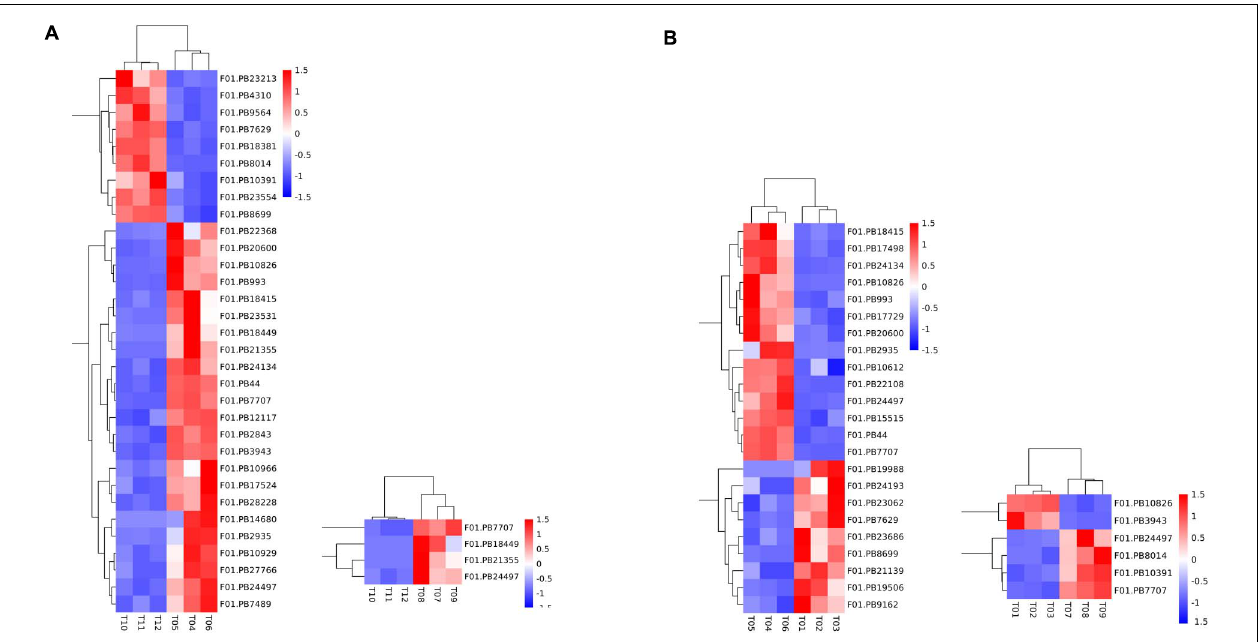
FIGURE 4 | Expression pattern analyses of the flowering-related DEGs. Heatmap of the expression patterns of 50 flowering-related DEGs in pairwise comparisons. (A) 32 flower-related genes differentially expressed between cold treated dark cultured and incubators cultured faba bean buds. (B) 23 genes were significantly highly expressed with cold treatment and dark